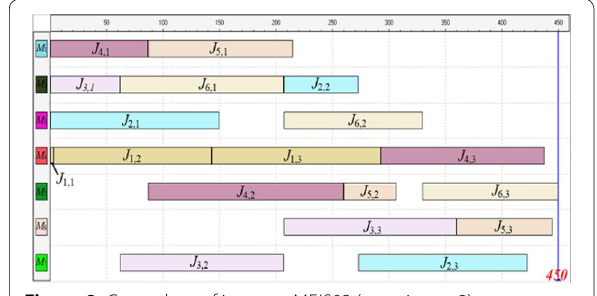
Figure 8 Gantt chart of instance MFJS03 (experiment 2)